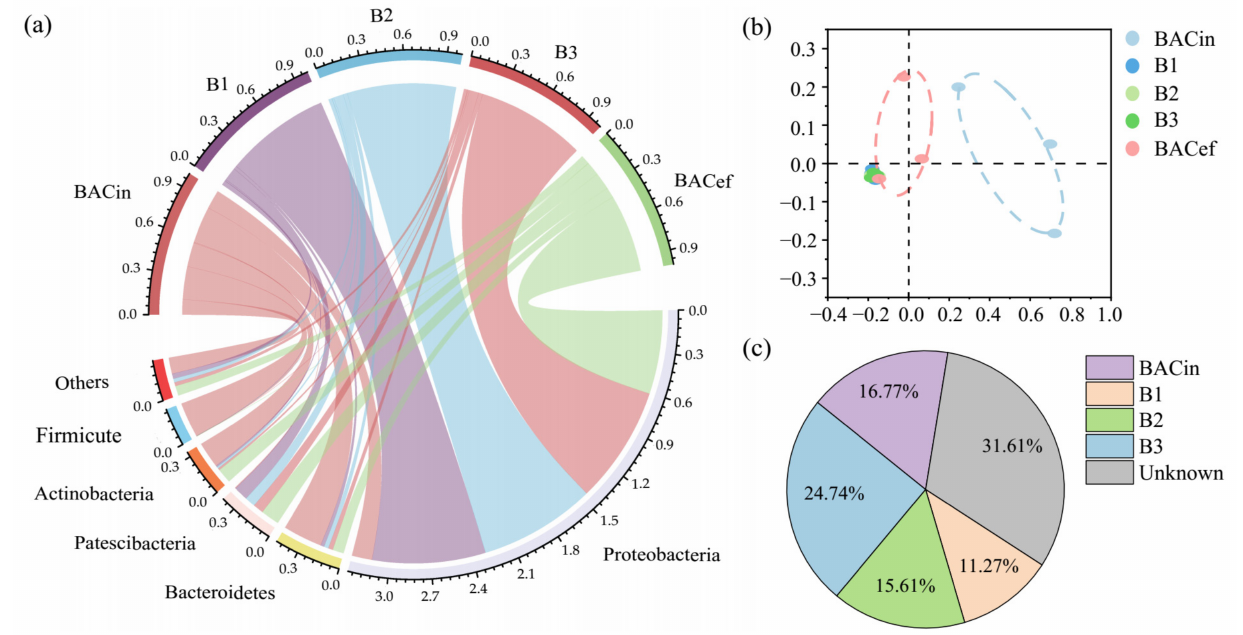
Figure 5. ( a ) Relative abundance of dominant taxa at the phylum level in BAC influents (BACin) and effluents (BACef) and biofilm samples from the top (B1), middle (B2) and bottom (B3) of the reactor. The data were visualized using the circlize package with R. The upper half circle represents every sample composition at phylum level, and the lower half circle indicates the proportion of a particular taxon in different samples. ( b ) Non-metric multidimensional scaling (NMDS) plot of BAC influents, effluents and biofilm samples based on Bray–Curtis distance. Symbol color represents different samples. ( c ) Results of SourceTracker analysis showing the contribution of BAC influents and different depth of biofilm samples to BAC